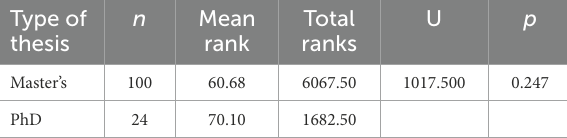
TABLE 10 U-Test results of similarity indexes of postgraduate theses in Austria grouped by thesis type. Type of